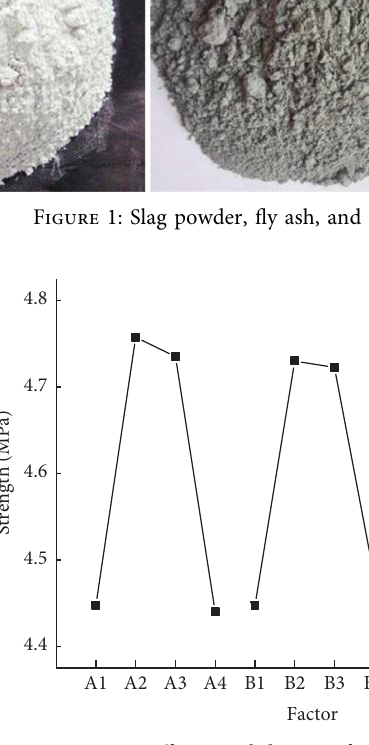
Figure 2: Main effect trend diagram for the flexural